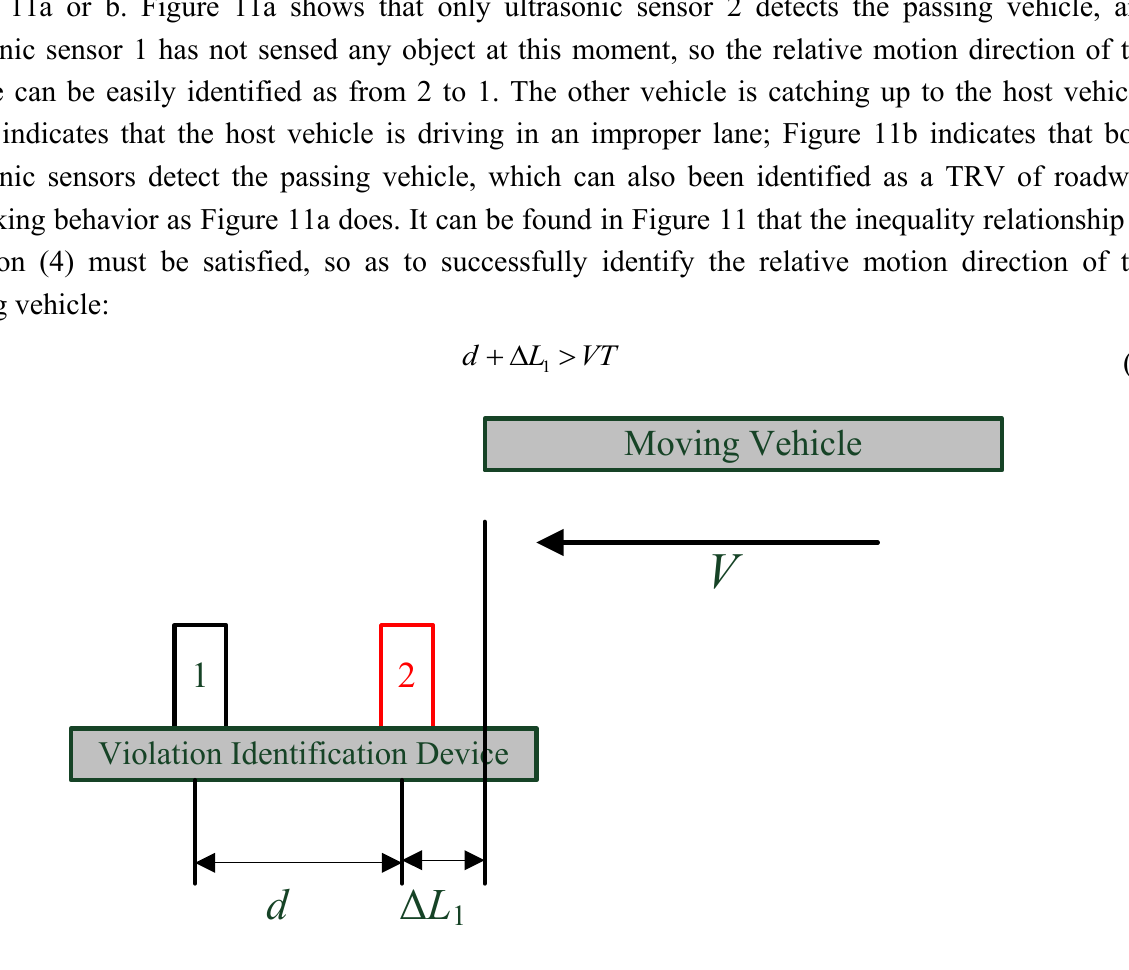
Figure 10. A vehicle is about to enter the measurement range of the sensor